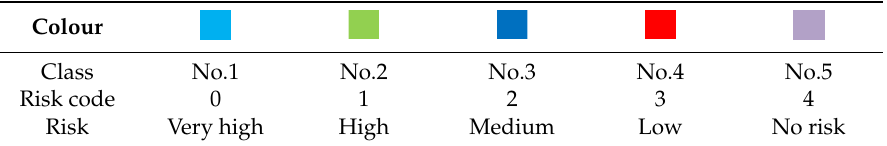
Table 1. Classes, symbols, and risk codes for steel bridges.